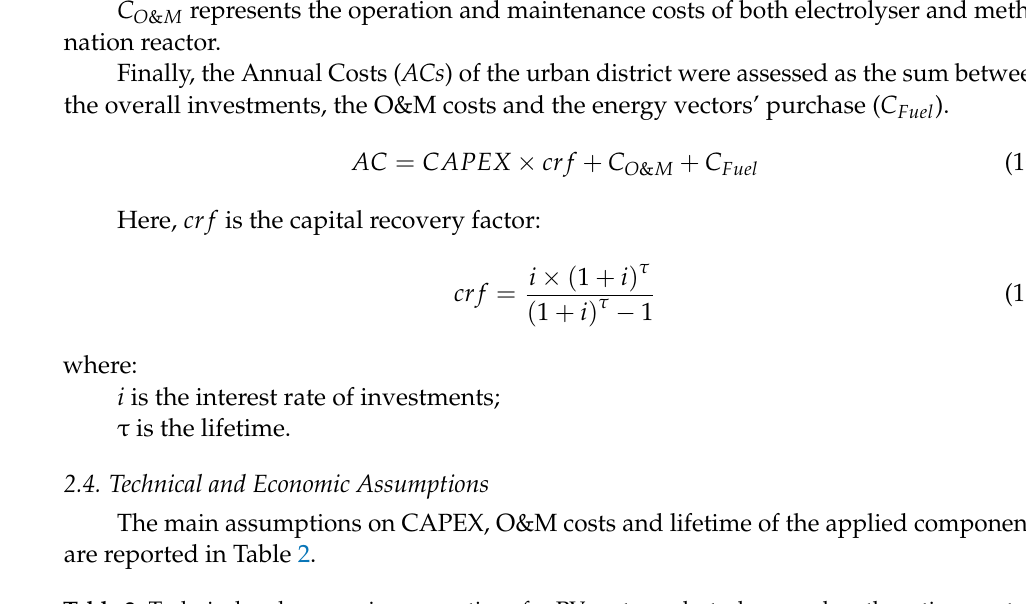
Table 2. Technical and economic assumptions for PV system, electrolyser and methanation reactor. PV System ALK Electrolyser Methanation